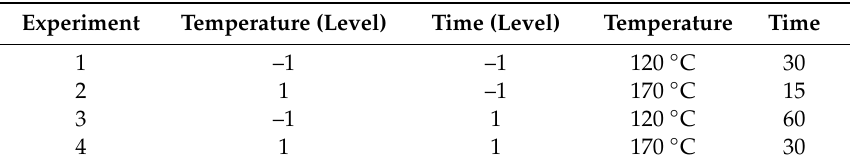
Table 1. Levels and conditions of the full factorial